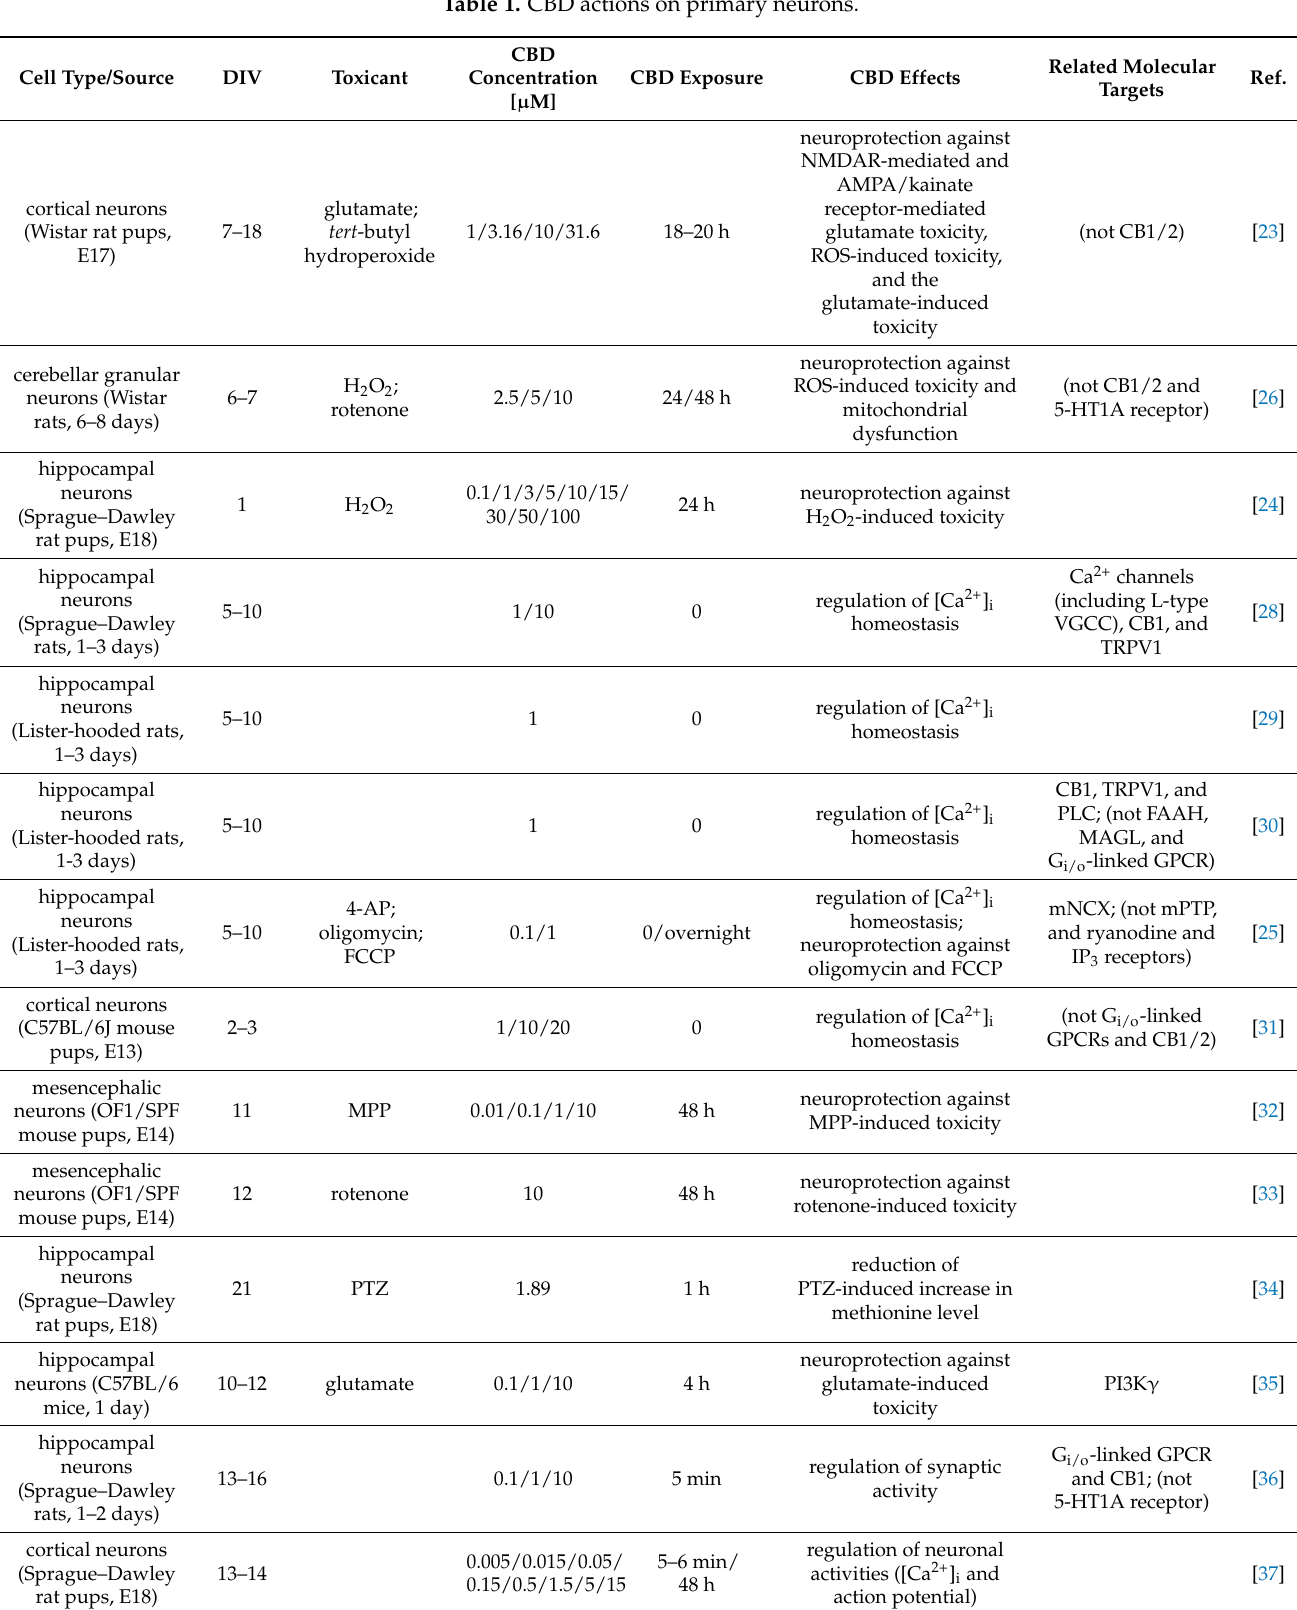
Table 1. CBD actions on primary